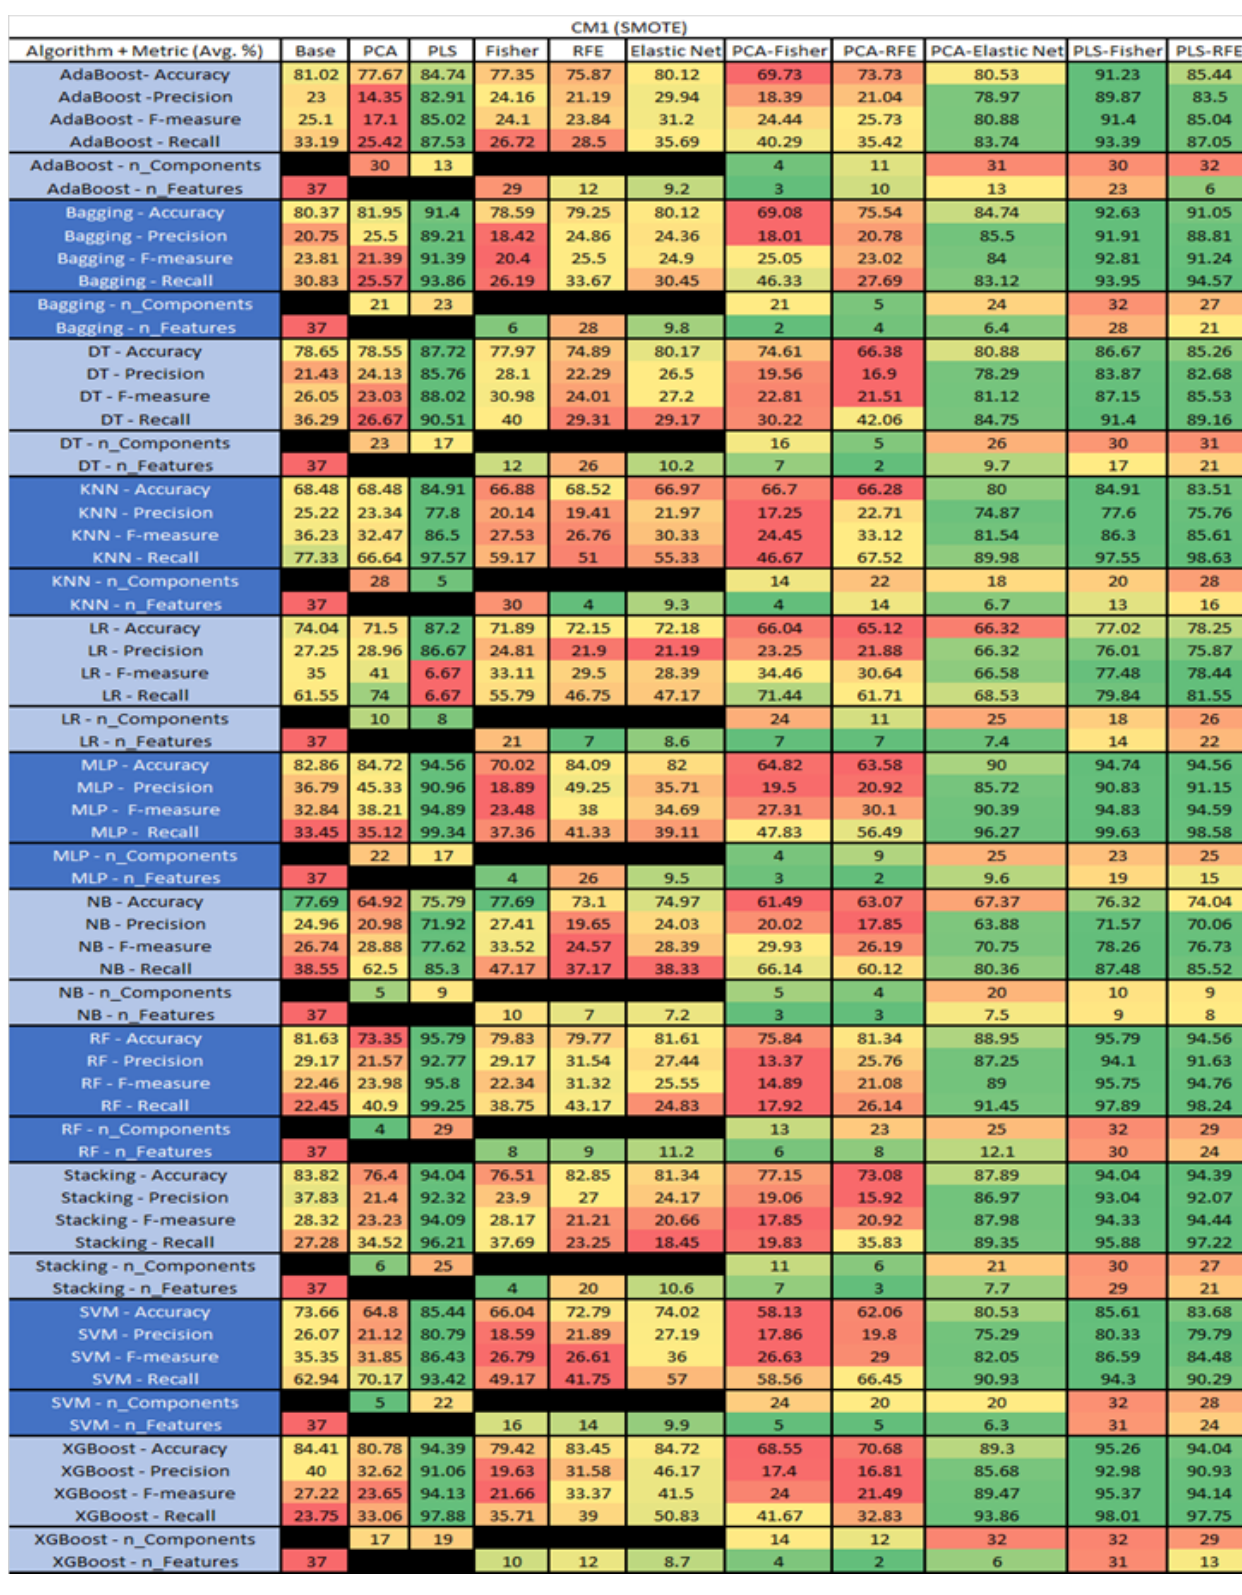
Figure 19. CM1 SMOTE NASA MDP Results Data